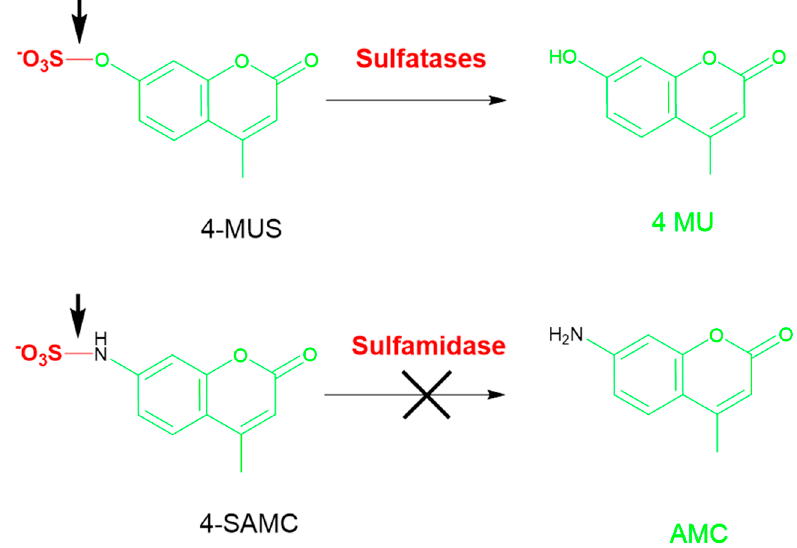
Figure 6. The common methylumbelliferyl sulfate (MUS) substrate. Multiple sulfatases are able to cleave the sulfate group in 4-MUS, as the only commonality is the sulfate group. Examples of specific substrates for ARSA (cerebroside galactosyl sulfate) and ARSB (GalS) are shown on the left. ARSA: arylsulfatase A; ARSB: N -acetyl galactosamine 4-sulfatase.